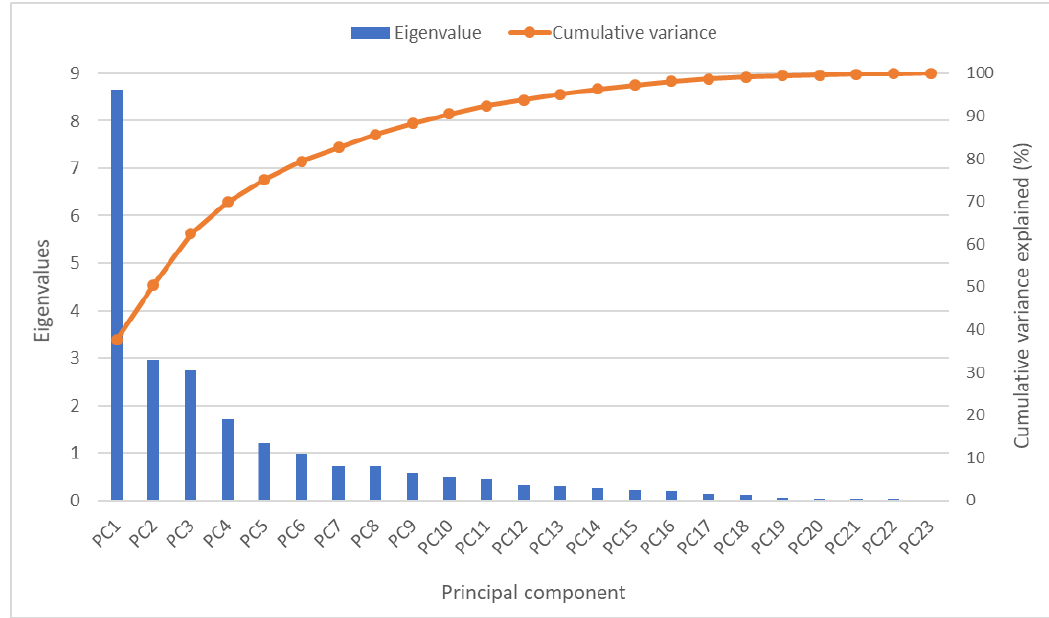
Figure 2. Eigenvalues and cumulative variance explained for 23 principal components from principal component analysis (PCA).